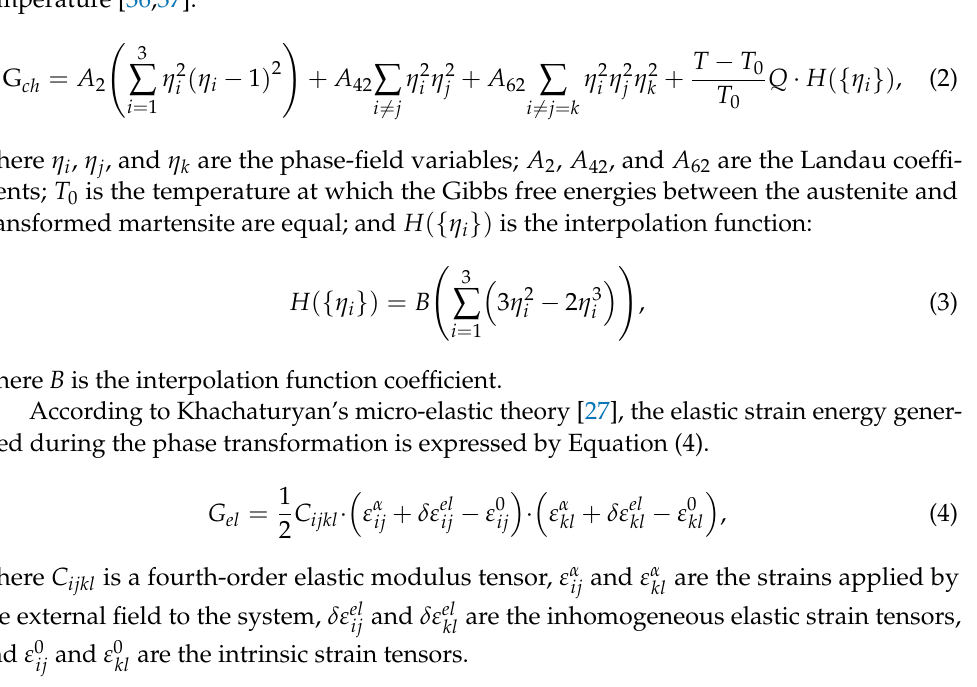
where η i , η j , and η k are the phase-field variables; A 2 , A 42 , and A 62 are the Landau coeffi- cients; T 0 is the temperature at which the Gibbs free energies between the austenite and transformed martensite are equal; and H ( { η i } ) is the interpolation function: